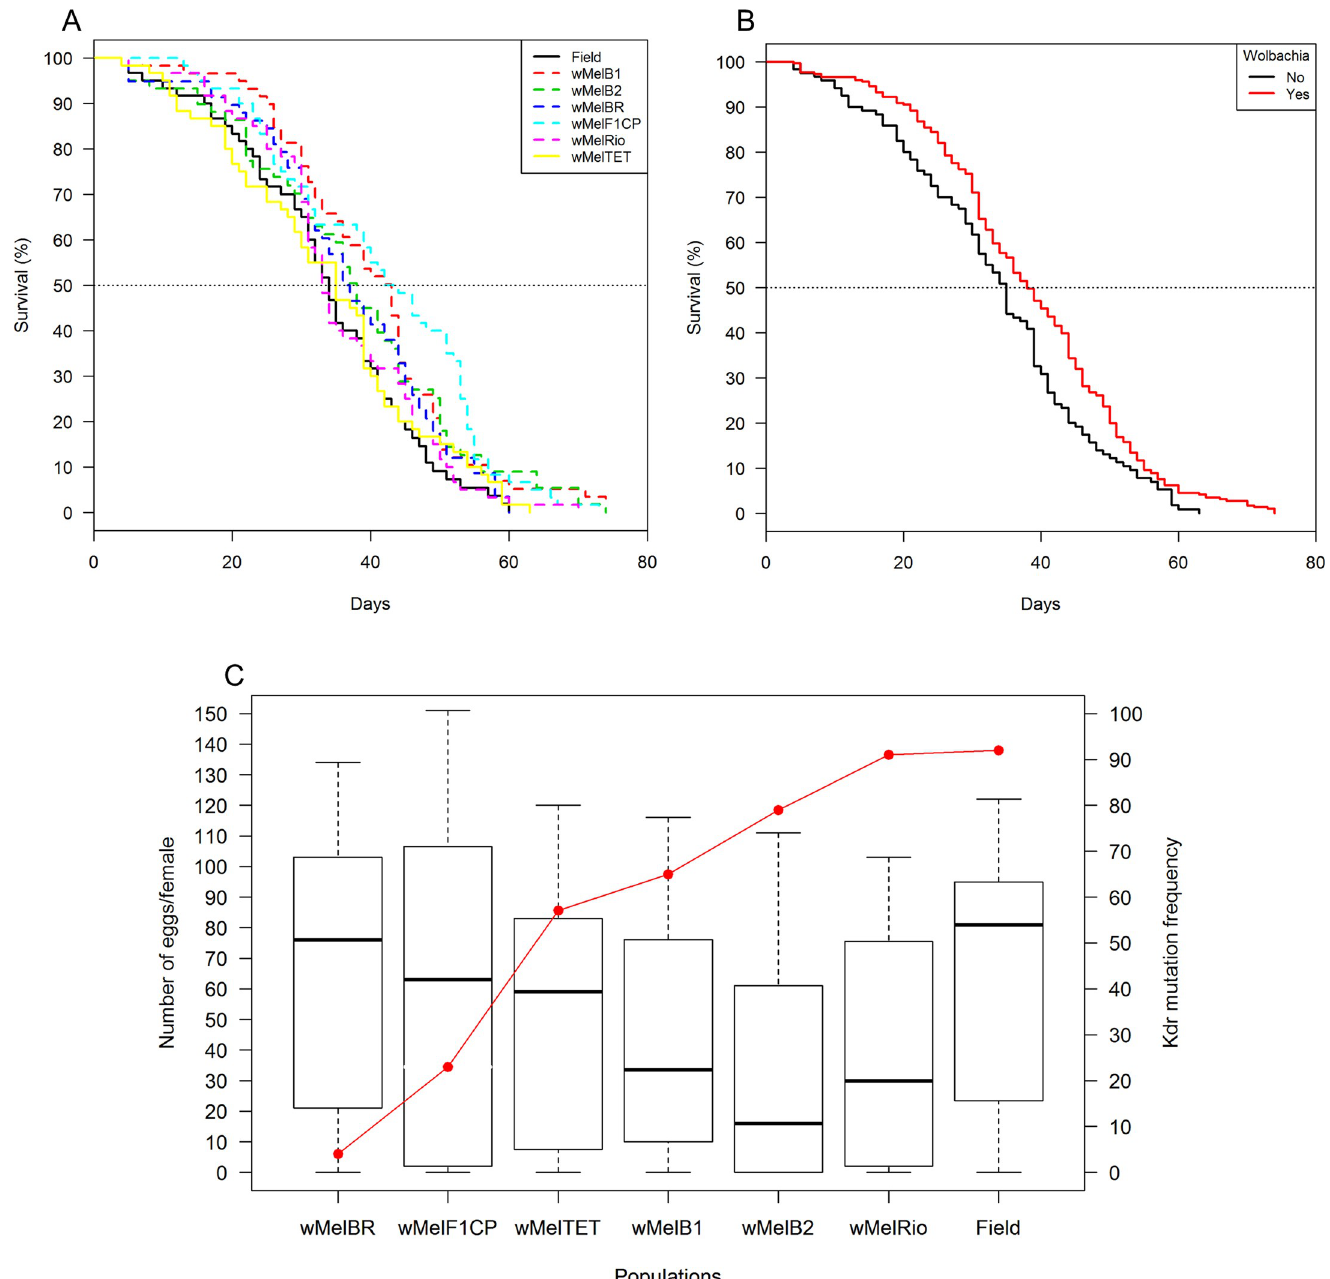
Fig 4. Survival curves of Aedes aegypti females from: (A) seven field populations from the backcrossing to produce an insecticide resistant line, (B) populations infected and uninfected with Wolbachia . (C) Number of eggs laid per Aedes aegypti female from the seven populations tested and the frequency of kdr mutation, represented by the red